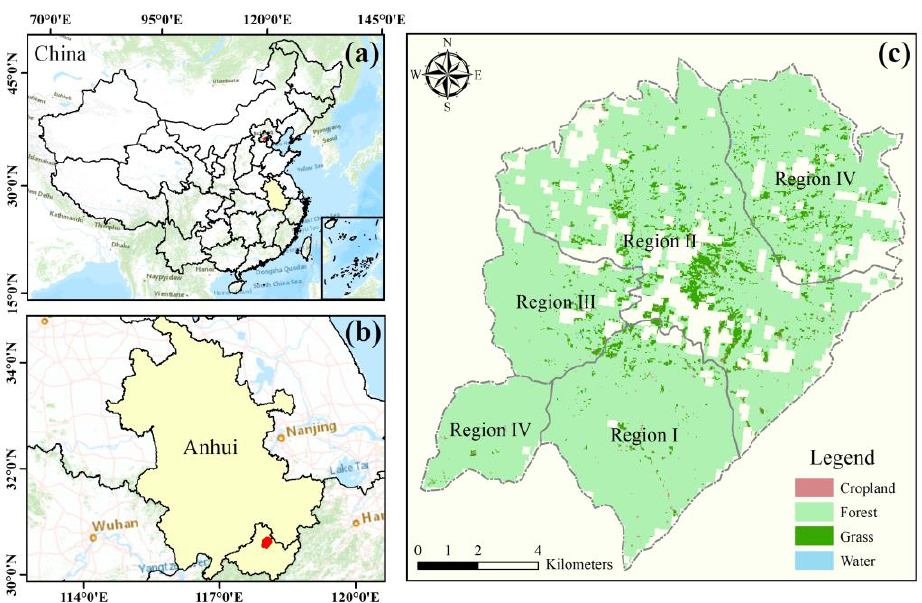
Figure 1. Overview map of the study area showing the location of the Anhui Province ( a ), the location of the Huangshan UNESCO Global Geopark (HUGG) ( b ), and the four types of ecosystems in the HUGG ( c ). Roman numerals in Figure 1c indicate the four levels of tourism resource development in the HUGG from 2000 to 2015.